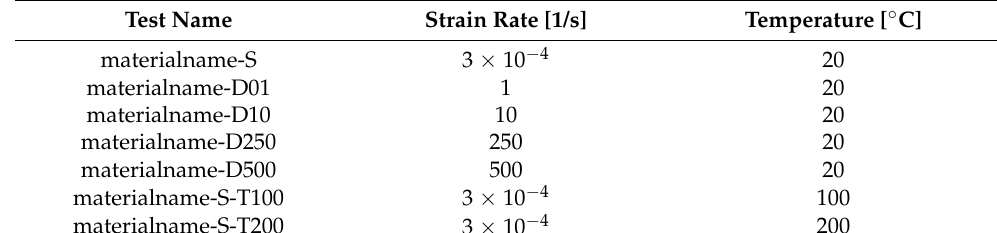
Table 1. Experimental campaign.